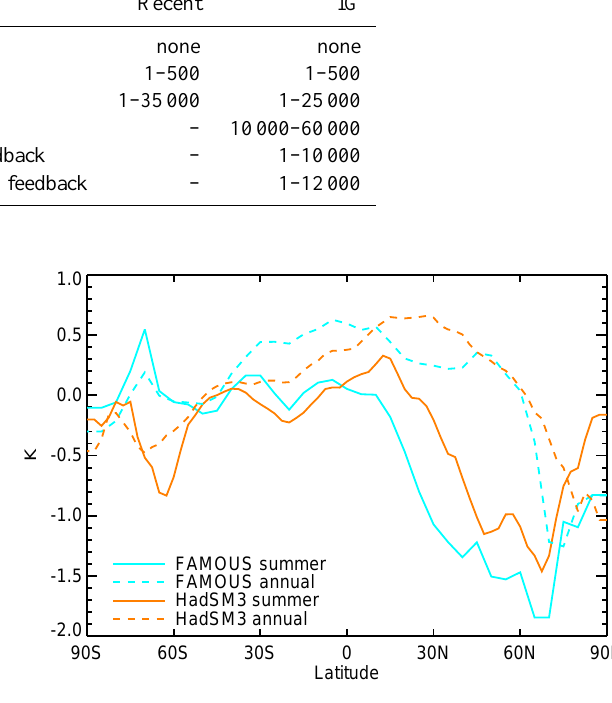
Fig. 2. Zonal-mean surface air temperature difference between the annual and summer (JJA) means of the incipient glacial and recent climates of FAMOUS and